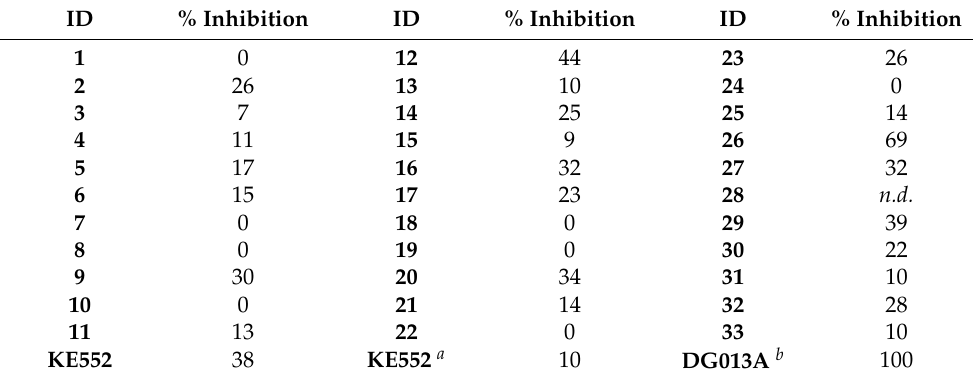
Figure 5. ( A ) Representative chromatograms of trimming of oxytocin by IRAP as monitored by HPLC. ( B ) Effect of compound 26 (inset) on the hydrolysis of 50 μ M Leu-AMC by IRAP and ERAP1, and on the hydrolysis of 50 µ M Arg-AMC by ERAP2. ( C ) Dose-dependent inhibition of IRAP trimming of oxytocin by compound 26. ( D ) Evaluation of the cellular toxicity of 26 using the MTT assay. Table 3. Inhibition of oxytocin trimming by IRAP in the presence of 1 – 33 and the two known inhibitors, DG013A and KE552, at a concentration of 100 µ